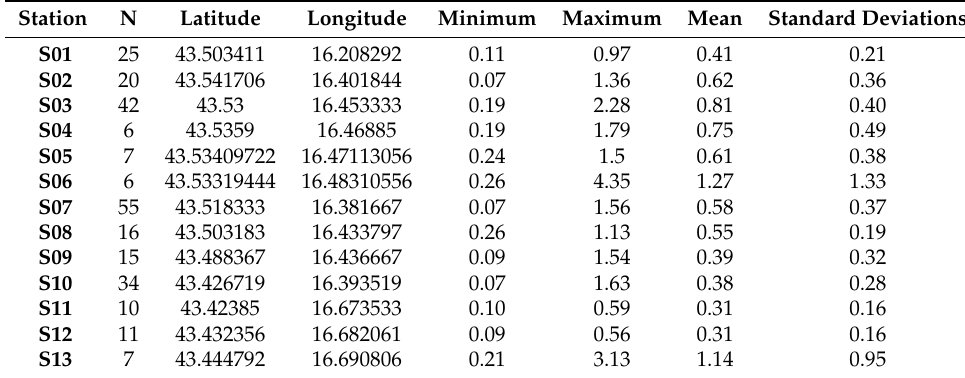
Figure 2. Map of in situ measuring stations distributed over the study area. Table 1. Summary statistic of in situ Chlorophyll-a